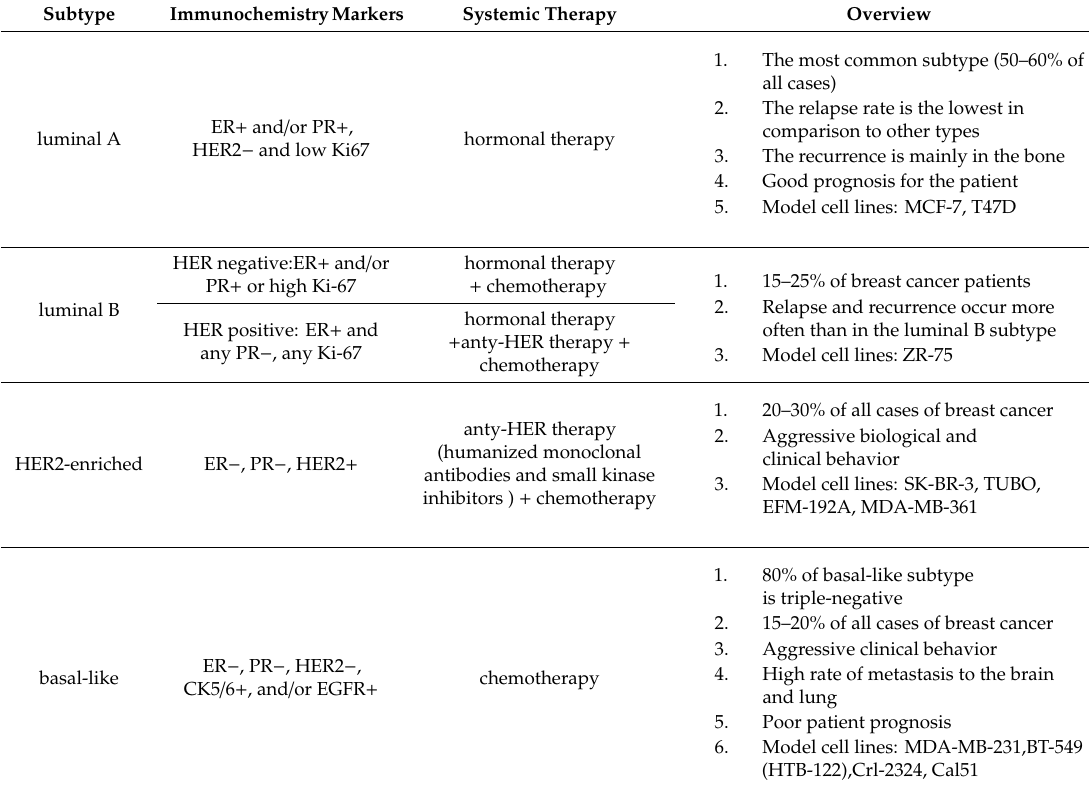
Table 1. Breast cancer classification, characterization, and model cell lines used in cancer treatment